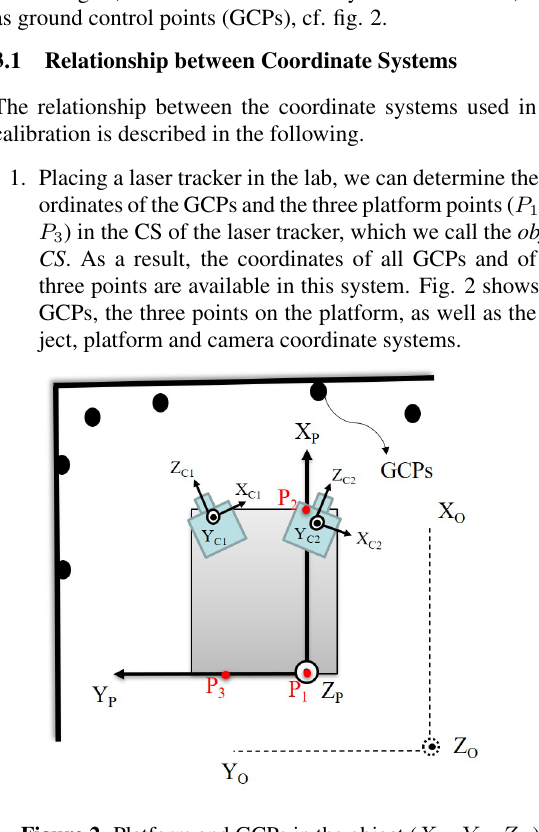
Figure 2. Platform and GCPs in the object ( X O , Y O , Z O ), platform ( X P , Y P , Z P ) and camera coordinate systems , Y C , Z C ( X C with i ∈ { 1 , 2 } i i i